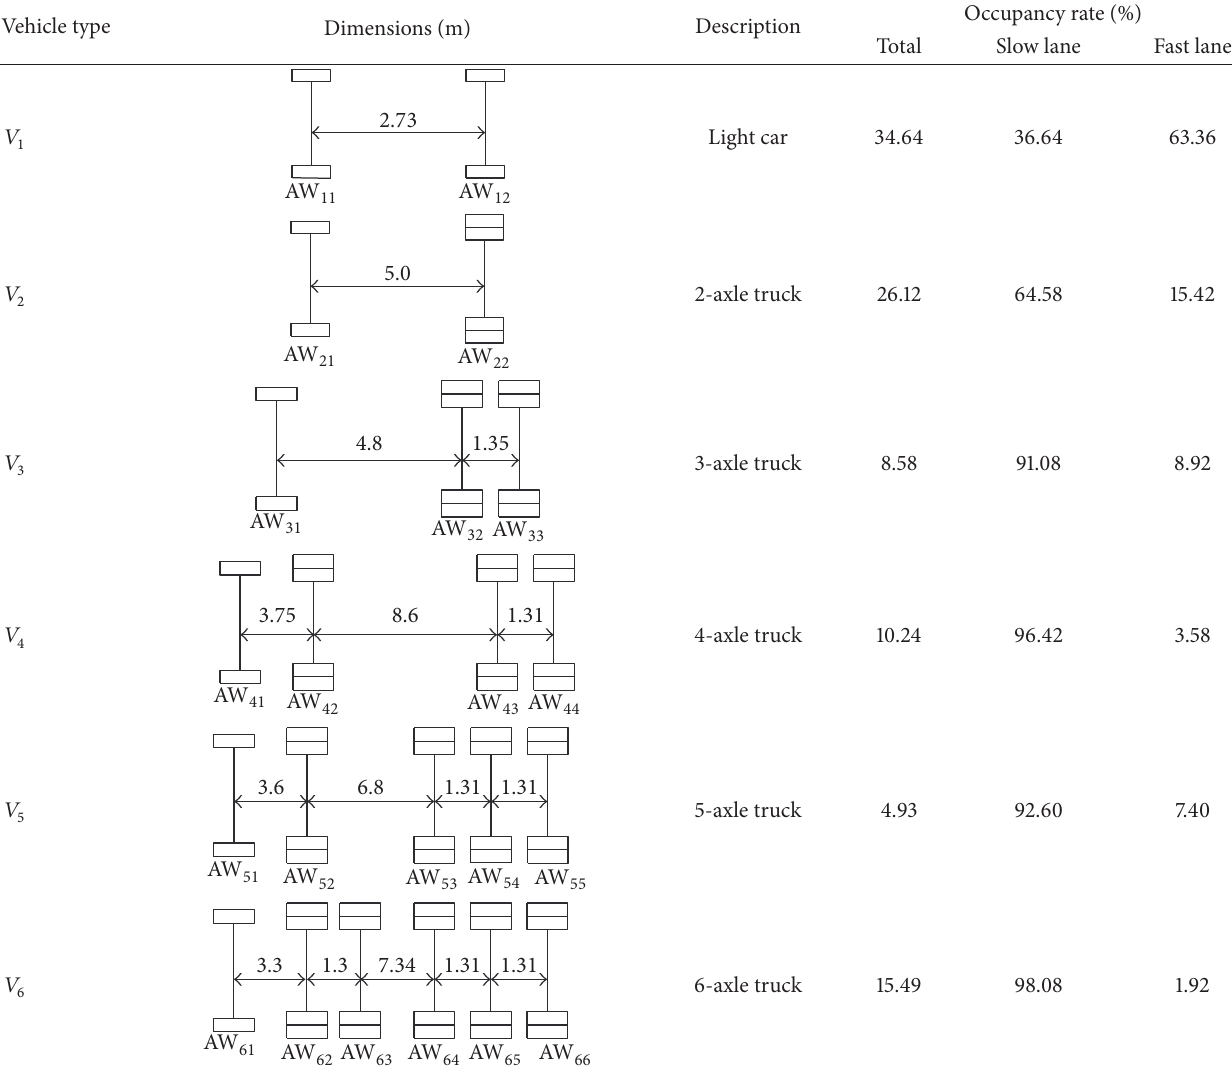
Table 2: Vehicle